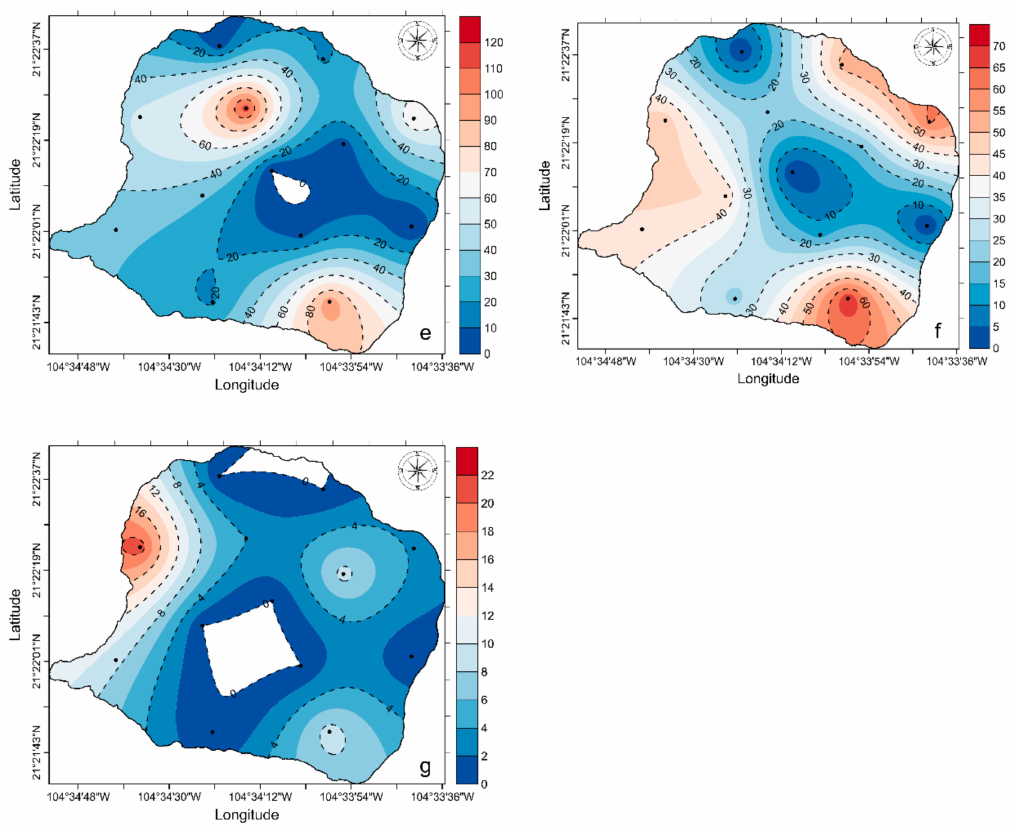
Figure 6. Surface distribution ( µ g / kg of dry weight) of microcystin congeners in algae mats in Santa Mar í a del Oro lake during March 2015. ( a ) MC-WR; ( b ) MC-LR; ( c ) MC-LA; ( d ) MC-HiIR; ( e ) MC-YR; ( f ) MC-LF; and ( g ) MC-LY distributions.